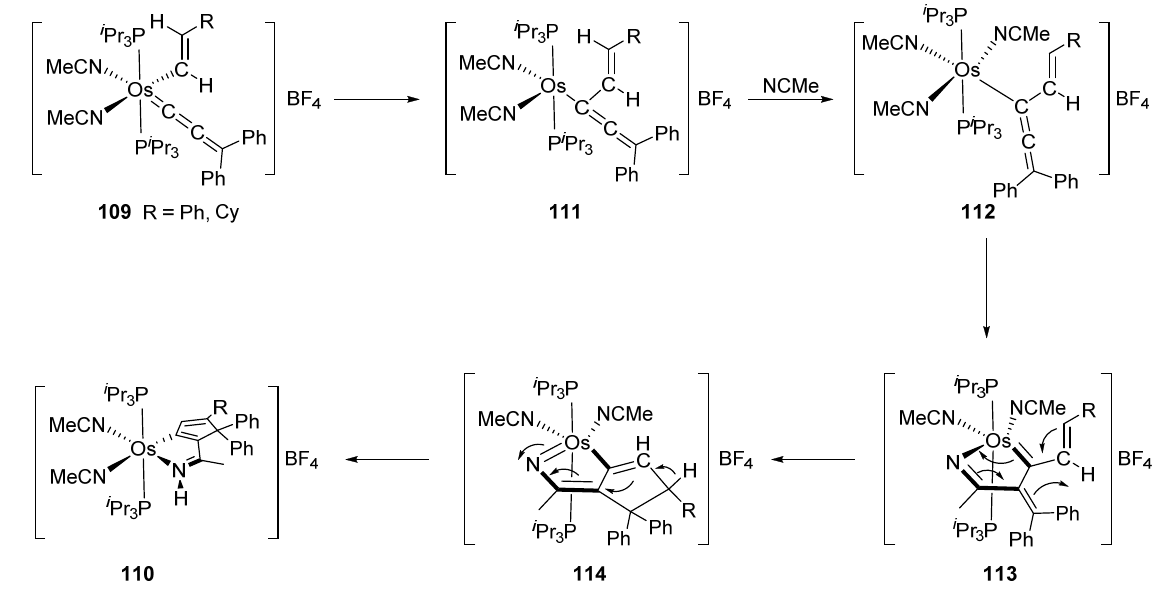
Figure 25. Synthesis of an osmacyclopentapyrrole complex from allenylidene derivative.